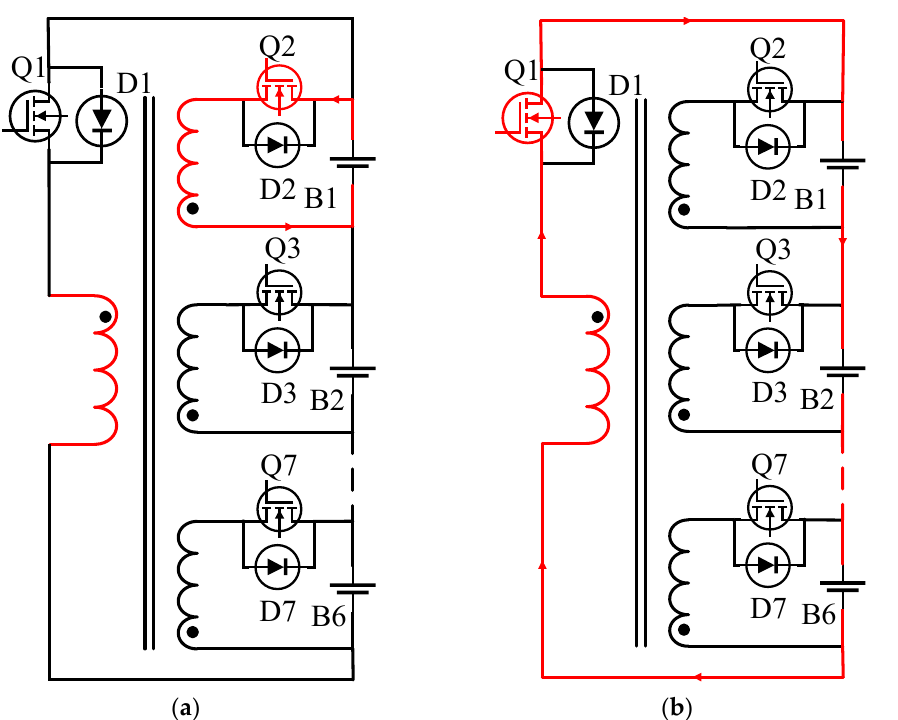
Figure 1. “Peak cutting“ equilibrium process. ( a ) “Peak cutting” equilibrium process I. ( b ) “Peak cutting” equilibrium process II.